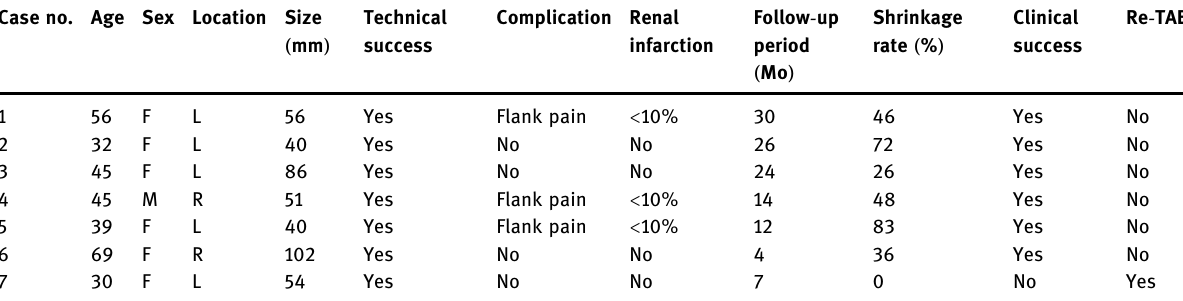
Table 1: Results of the TAE using microspheres for renal AMLs Case no. Age Sex Location Size ( mm